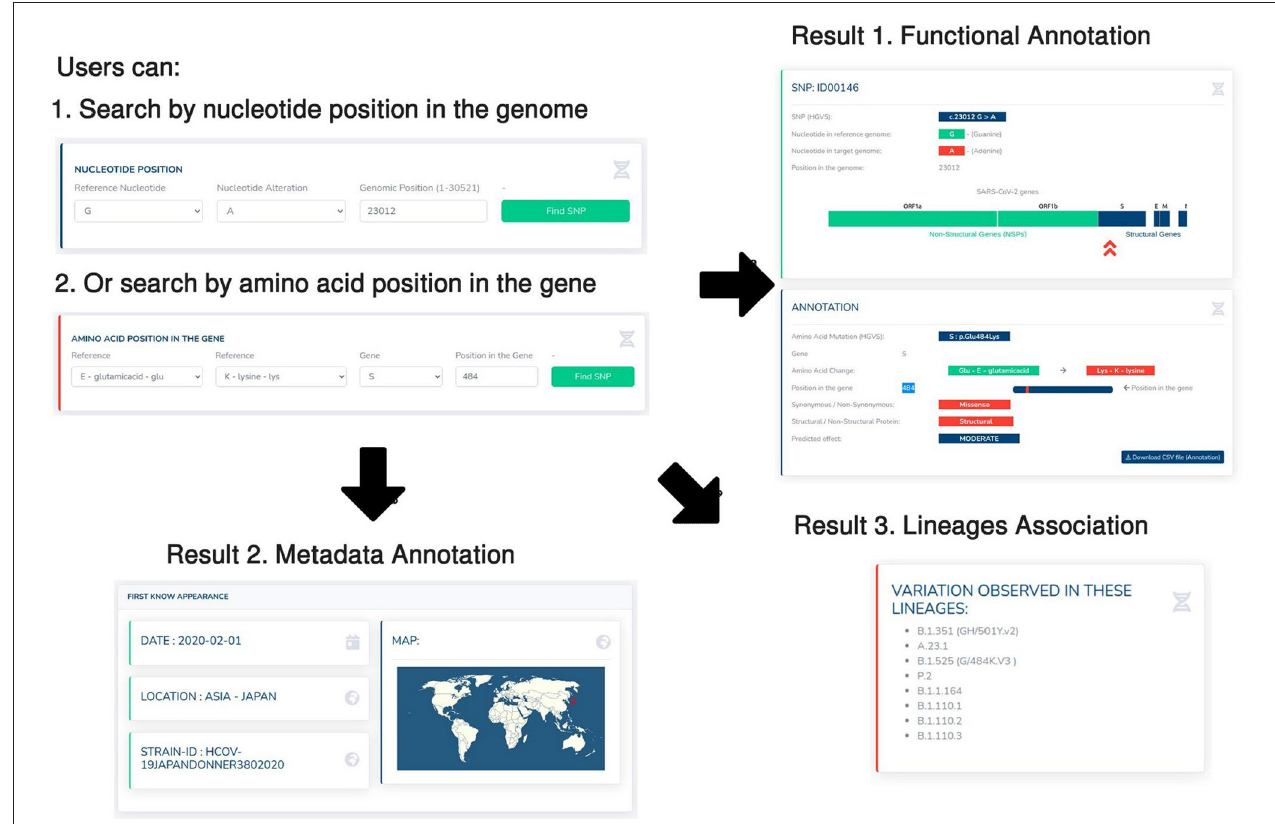
FIGURE 3 | Case study of the 23012G > A variant. Screenshots from IDbSV web-portal providing contextual information about IDbSV c.23012G > A coding for the variation E484K in spike glycoprotein region. The users can start by searching for a genetic variation using its position in the genome (1), or its amino acid position in a specific gene (2). The database automatically returns three main results: (1) the functional annotation of the selected mutation (Position in the genome, associated amino acid mutation, type of mutation, predicted effect), (2) geographic and time information about the first known appearance of the selection variation, (3) the associated lineages with the selected